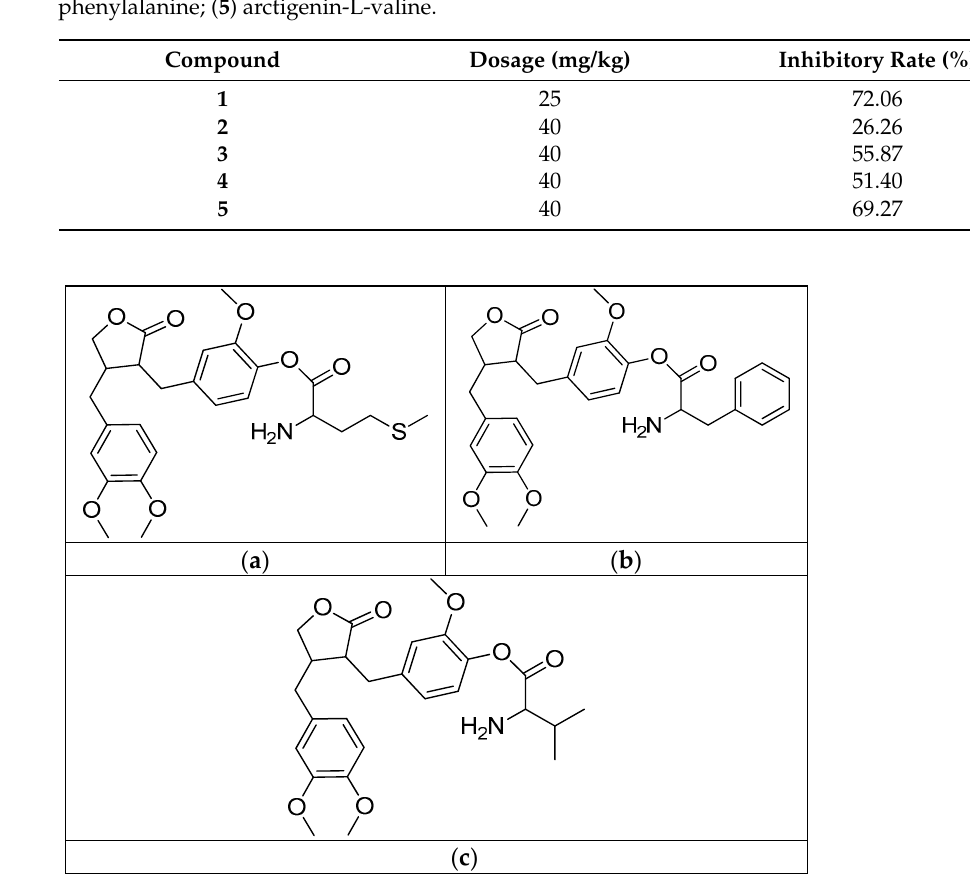
Figure 22. ( a ) Arctigenin-L-methionine; ( b ) arctigenin-L-phenylalanine; ( c ) arctigenin-L-valine.